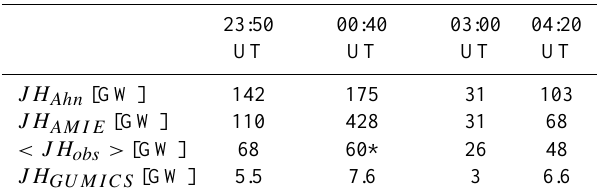
Table 1. Estimates of total Joule heating for the 28–29 March 1998 event using different techniques.